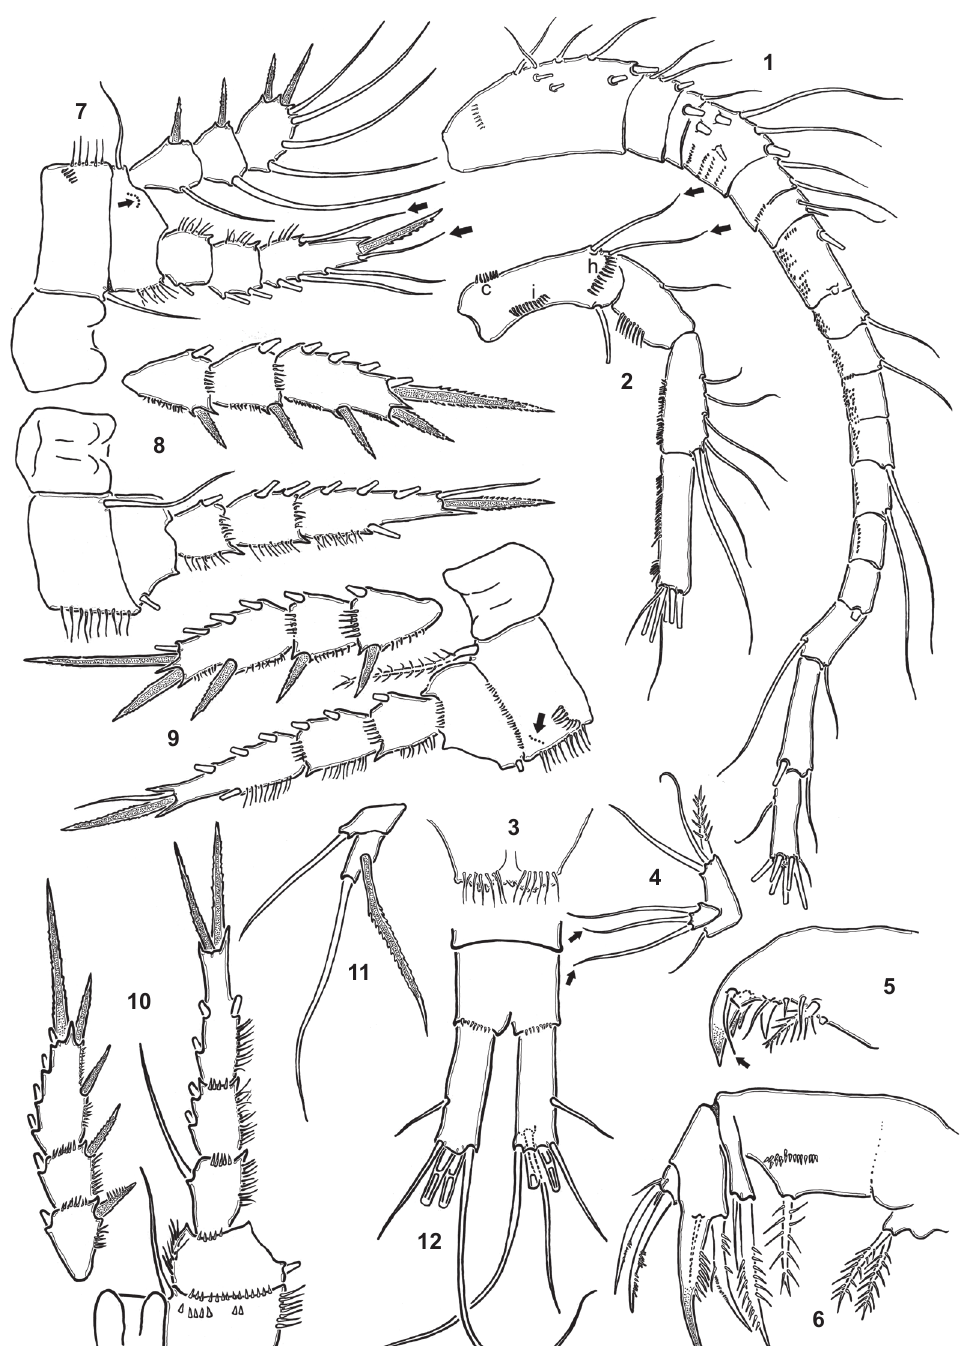
Figures 1-12. Mesocyclops thermocyclopoides , adult female from El Arenal, Costa Rica: (1) antennule; (2) antenna, showing spinal rows c , h , i and medial basipodal setae; (3) labrum, anterior view; (4) maxillule palp (medial and outer seta arrowed); (5) maxillule; (6) maxilla; (7) first swimming leg (P1), frontal view, curved row of basipodal spinules arrowed; (8) second swimming leg (P2); (9) third swimming leg (P3); (10) fourth swimming leg (P4); (11) fifth leg; (12) anal somite and caudal rami, ventral ZOOLOGIA 28 (5): 673–679, October, 2011